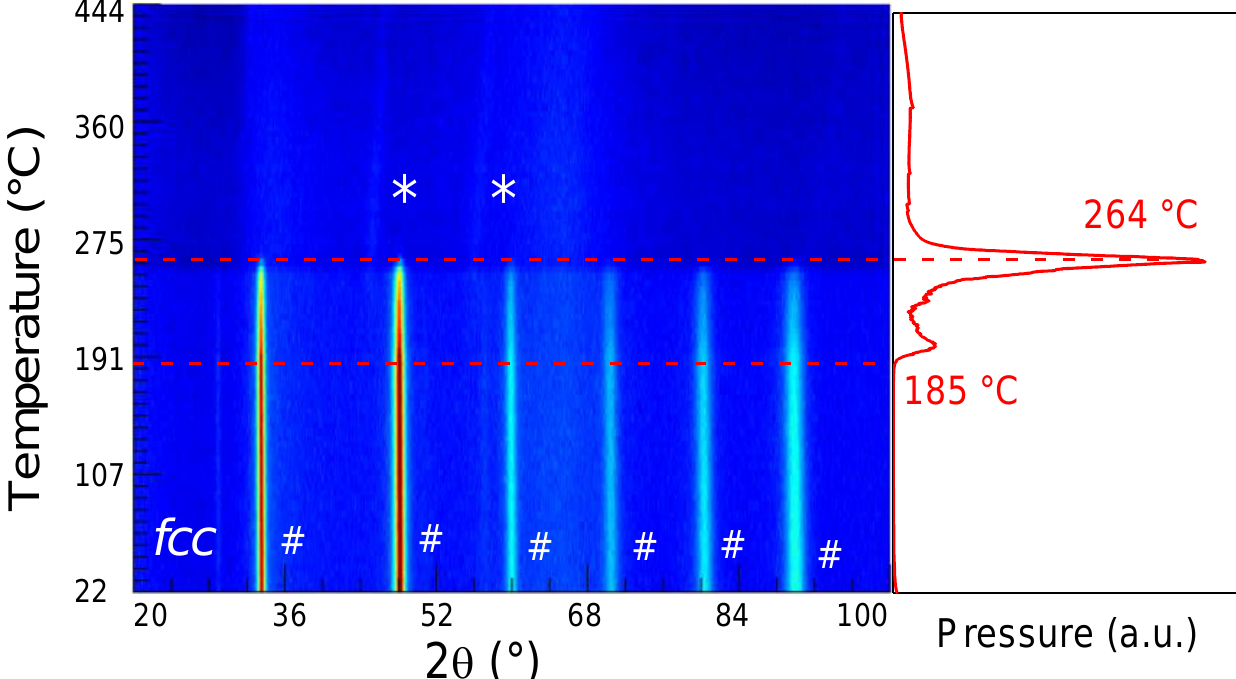
Figure 6. In situ neutron diffraction ( λ = 1.2858 Å) of Ti 0.30 V 0.25 Cr 0.10 Zr 0.10 Nb 0.25 D 2 during heating under dynamic vacuum from 22 ◦ C to 445 ◦ C with 1 ◦ C/min (left) and the corresponding desorption profile (right). The symbol # indicates the initial fcc deuteride whereas, the stars indicate the desorbed phase.